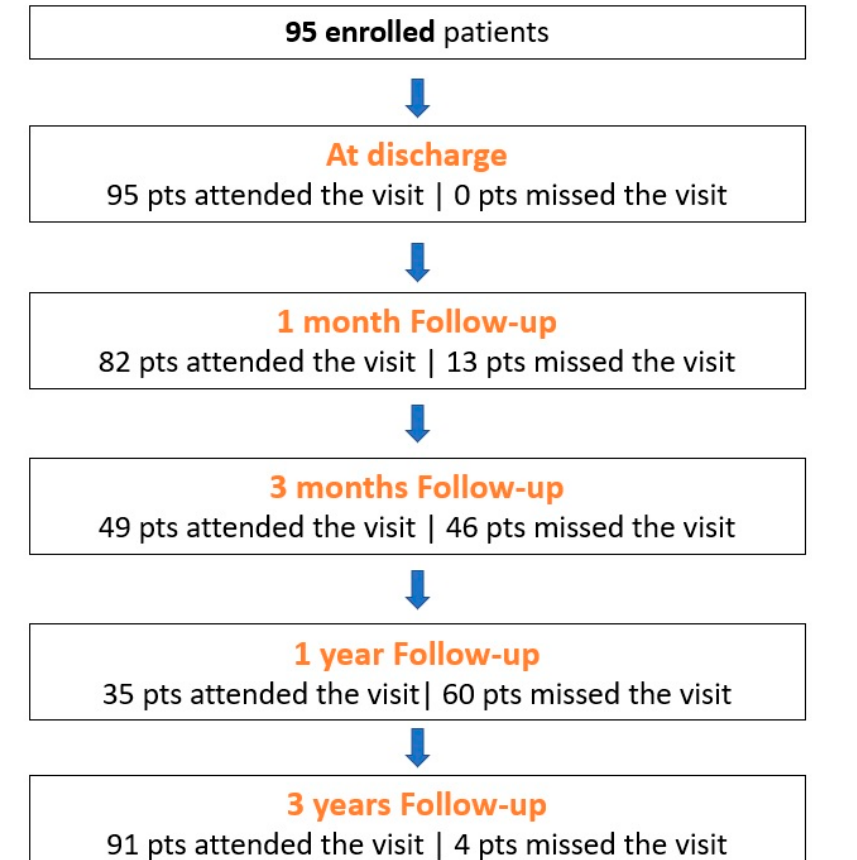
Figure 2. Study flow: up to 3 years of follow-up. It is of note that at the final follow-up, the four Figure 2. Study fl ow: up to 3 years of follow-up. It is of note that at the fi nal follow-up, the four patients who missed the visit had passed away. Pts: patients who missed the visit had passed away. Pts: patients.